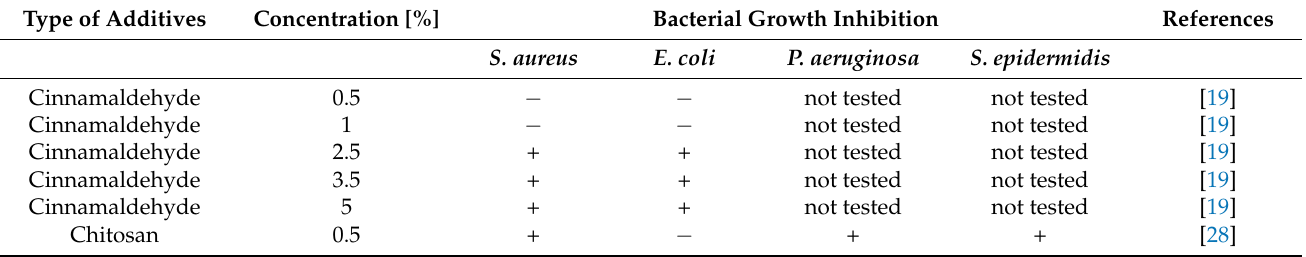
Table 2. Methods of polyurethane modification to obtain antibacterial properties of the material. Type of